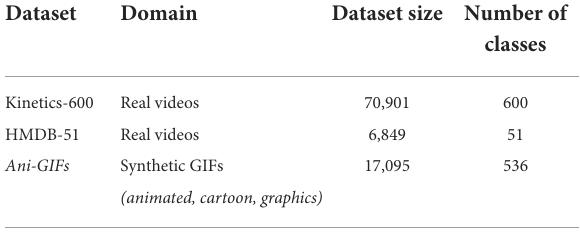
TABLE 1 Comparing our proposed benchmark to existing ones for spatiotemporal action